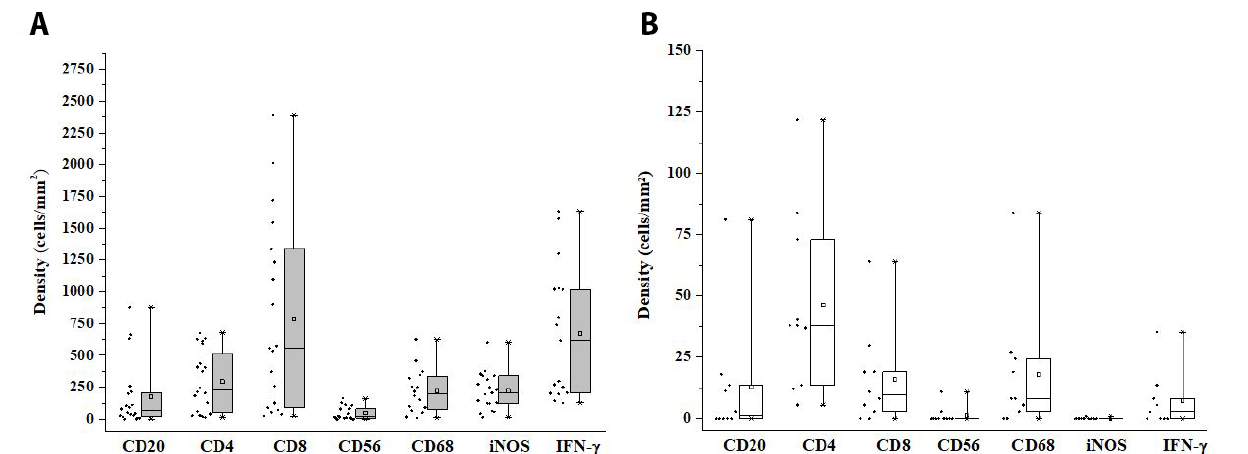
Figure 4. Dot plot graph showing the distribution of positive cells and a box plot showing the median, mean, quartiles, maximum and minimum values for the number of positive cells per square millimetre for CD20, CD4, CD8, CD56, CD68, iNOS and IFN-γ markers in (A) skin lesion of non-ulcerated cutaneous leishmaniasis and (B) skin of healthy